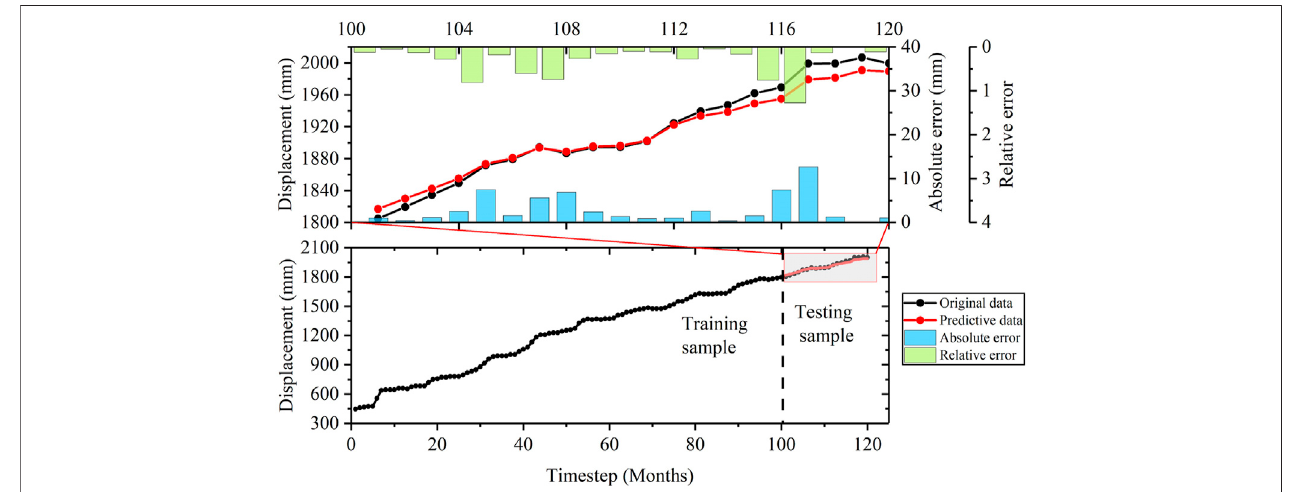
FIGURE 10 | Plots highlighting the prediction of the cumulative displacement.